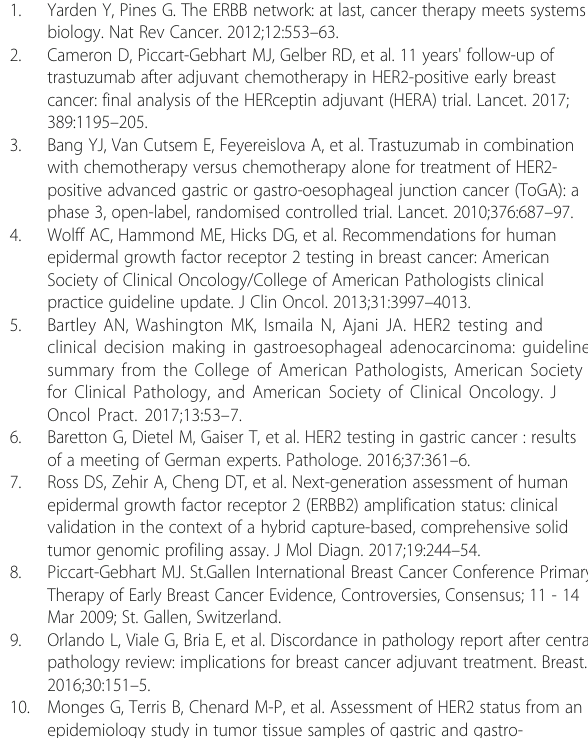
Additional file 2: Figure S2. Width of HER2 DAB-precipitates and result of in situ hybridization (ISH). Histograms of n = 1200 measurements in